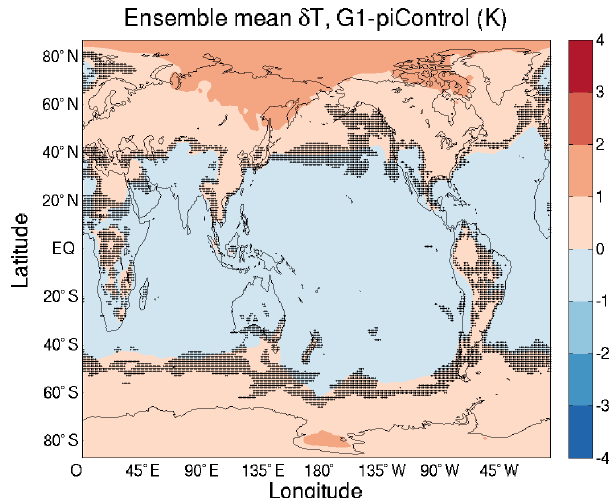
Figure 1. The annual mean distribution of near-surface atmospheric temperature anomalies (K) between G1 (years 11–50) and piControl (all years). The stippling denotes regions where fewer than 66% of the 12 ensemble members agree on the sign of the change. These results appear in Kravitz et al. (2013a).